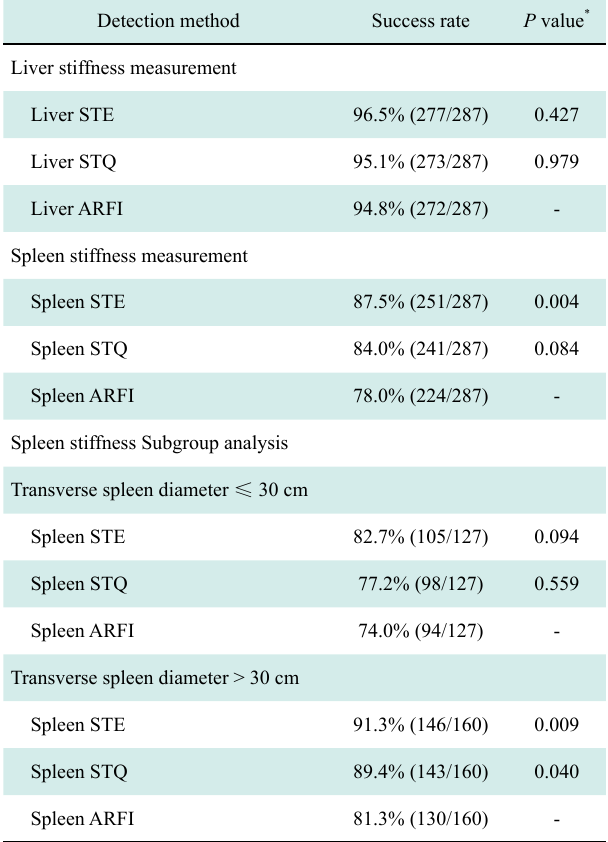
Table 1 Comparison of different detection methods for success rate Detection method